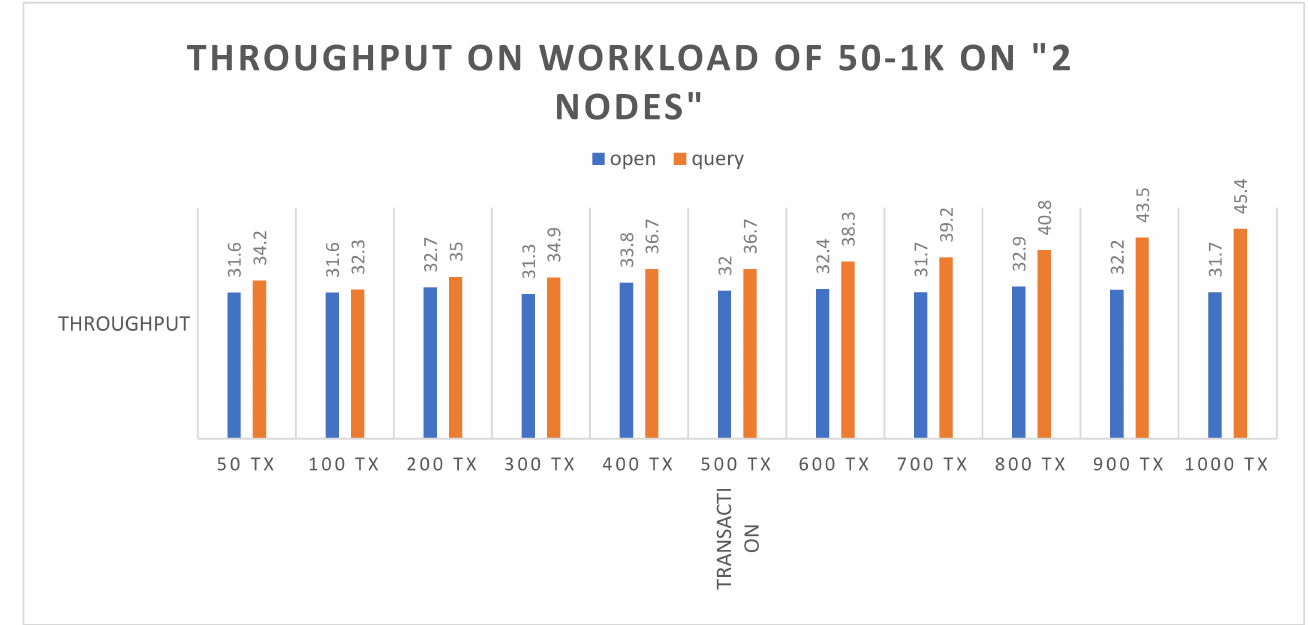
Figure 4. Transaction throughput on the open and the query